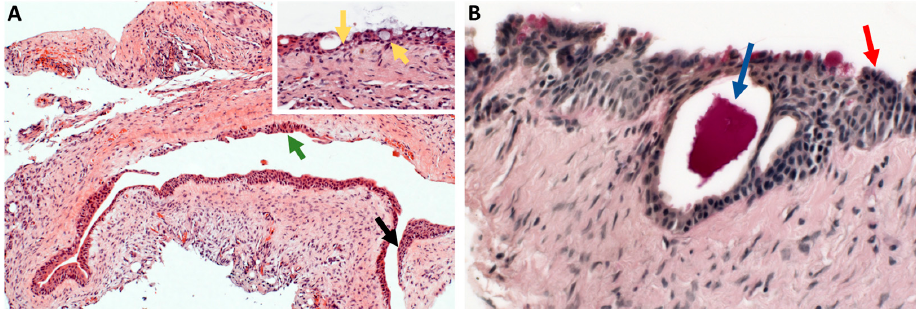
Figure 2. Photomicrographs of the histopathological analysis, detailing the morphological features. ( A )—Hematoxylin and eosin (H&E) staining: Thin connective tissue capsule lined by strati fi ed epi- thelium that is partly squamous (black arrow), partly cuboidal (green arrow). The epithelium also presented areas of thickening and papillary projections towards the lumen (100× in the original). Inset shows the presence of mucous cells and duct-like structures (yellow arrows) (400×). ( B )—PAS- diastase staining evidenced hobnail cells (red arrow) on the epithelial surface and mucin- fi lled intra- epithelial duct-like structures (blue arrow).